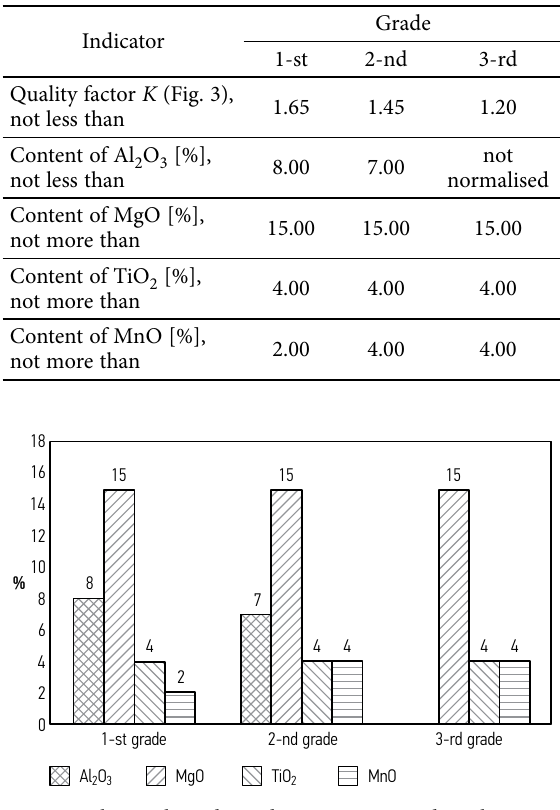
Fig. 2. Slag analysis depending on compounds inclusion, according to the Ukrainian Standard GOST 3476-74